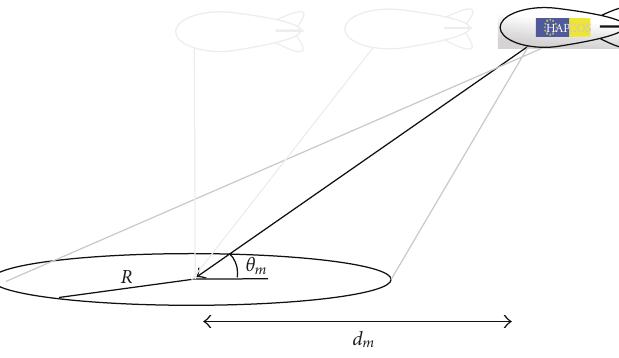
Figure 4: A plot illustrating the change of HAP position d m to create di ff erent elevation angles θ m .